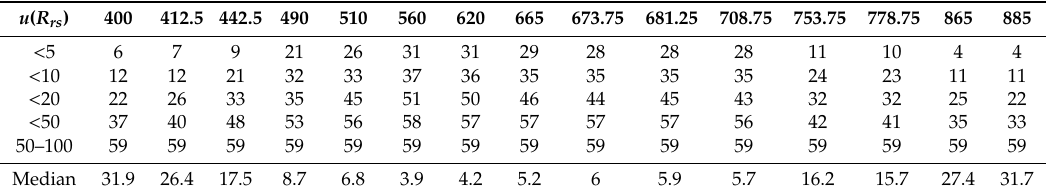
Table A1. Cumulative frequency of measurements with categorized uncertainty estimate, u ( R rs ), for every OLCI band. The lowest row shows the median uncertainty for every band. Total 59 in situ